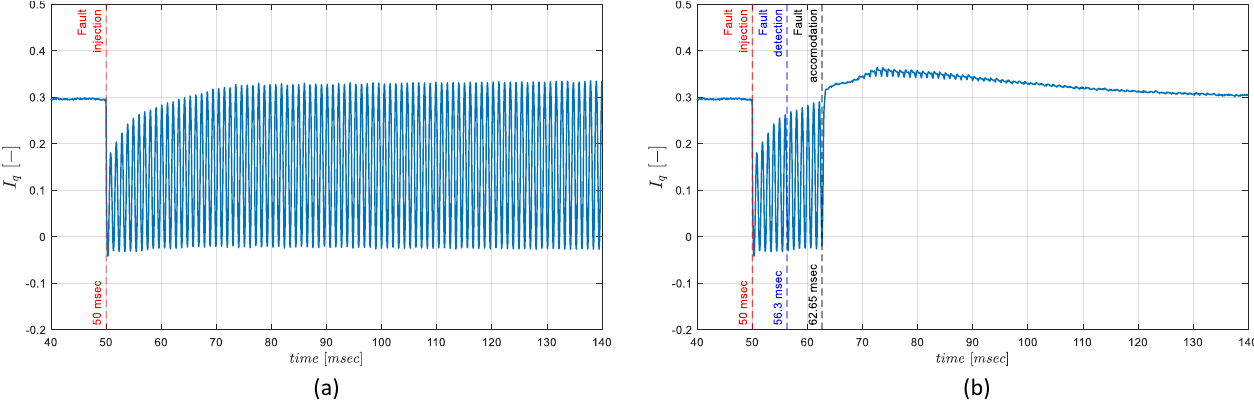
Figure 14. Normalized quadrature current with open circuit on phase a at t = 50 msec ( I lim = 92 A): ( a ) without FTC, ( b ) with FTC.